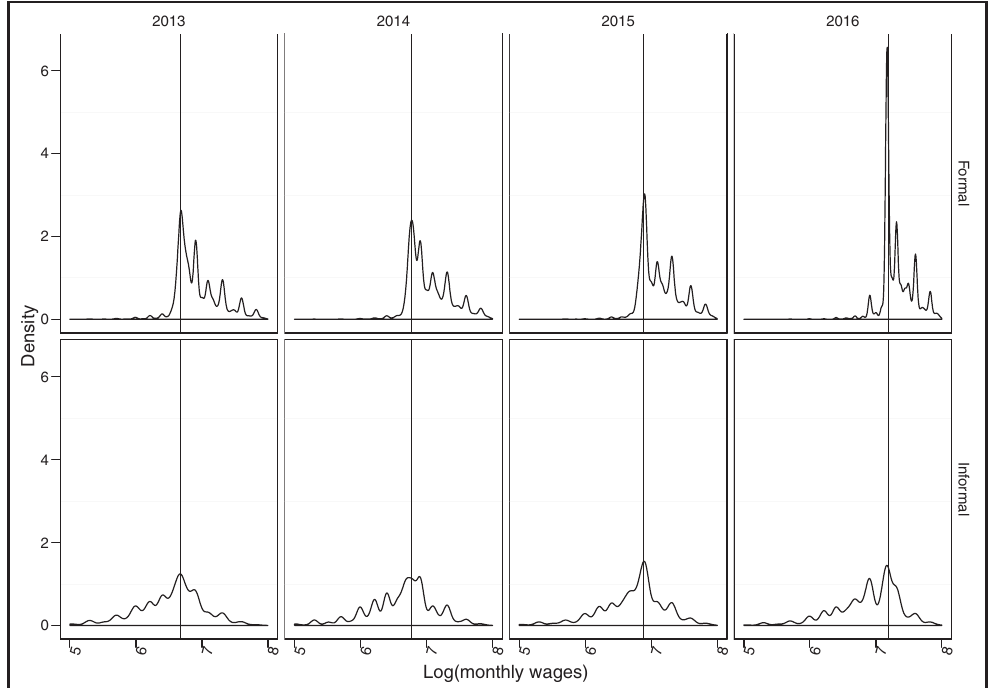
Figure 5 Wage distribution in full-time wage employment in the private